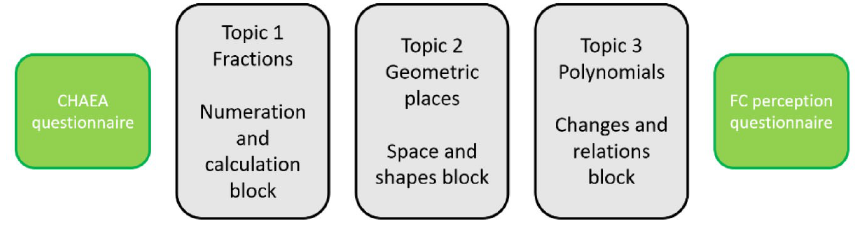
Figure 1. Distribution of instruments during the